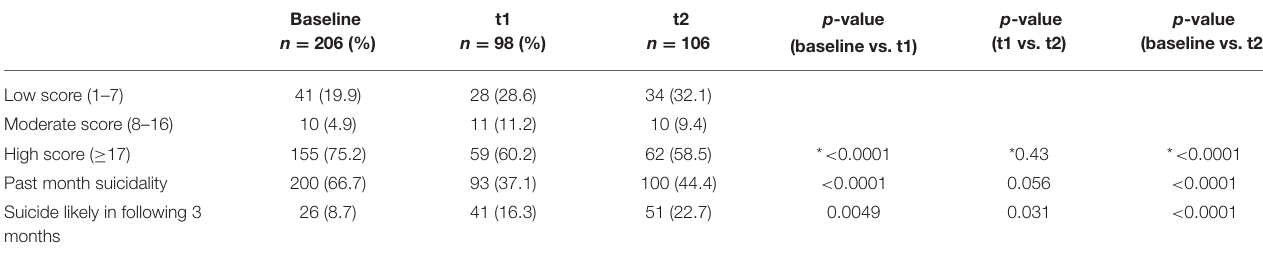
TABLE 2 | Categories of SIB over